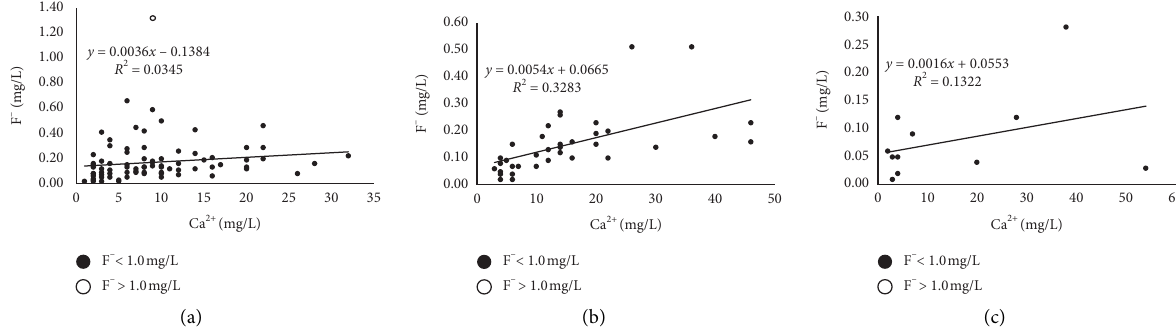
Figure 6: Relationship between F − and Ca 2+ in groundwater of different subsystems. (a) Groundwater subsystem of Suishui River. (b)